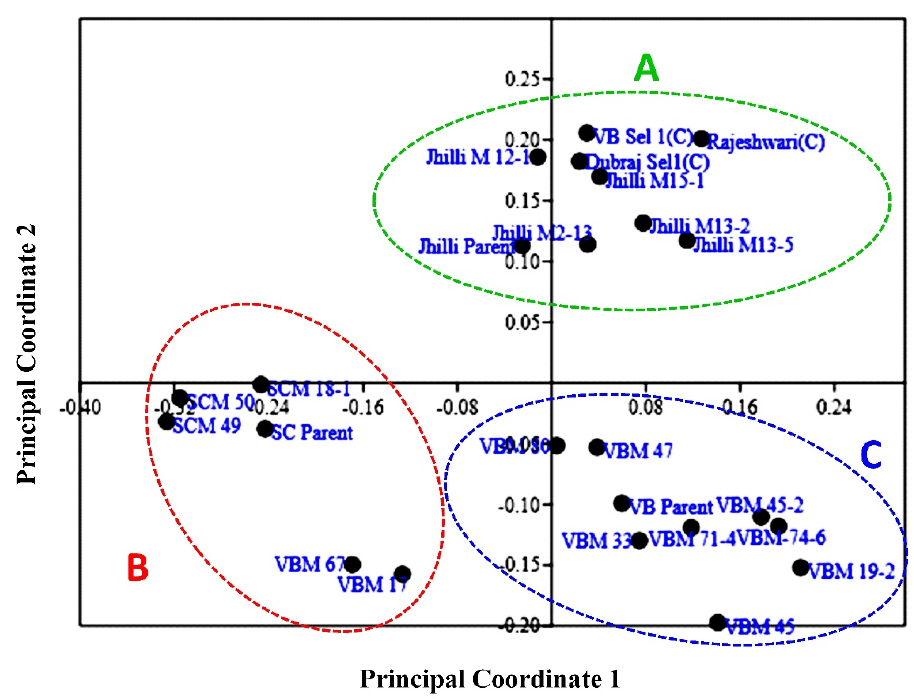
Figure 10. PCA scatter diagram showing the grouping pattern of rice mutants and parents based on SSR markers.